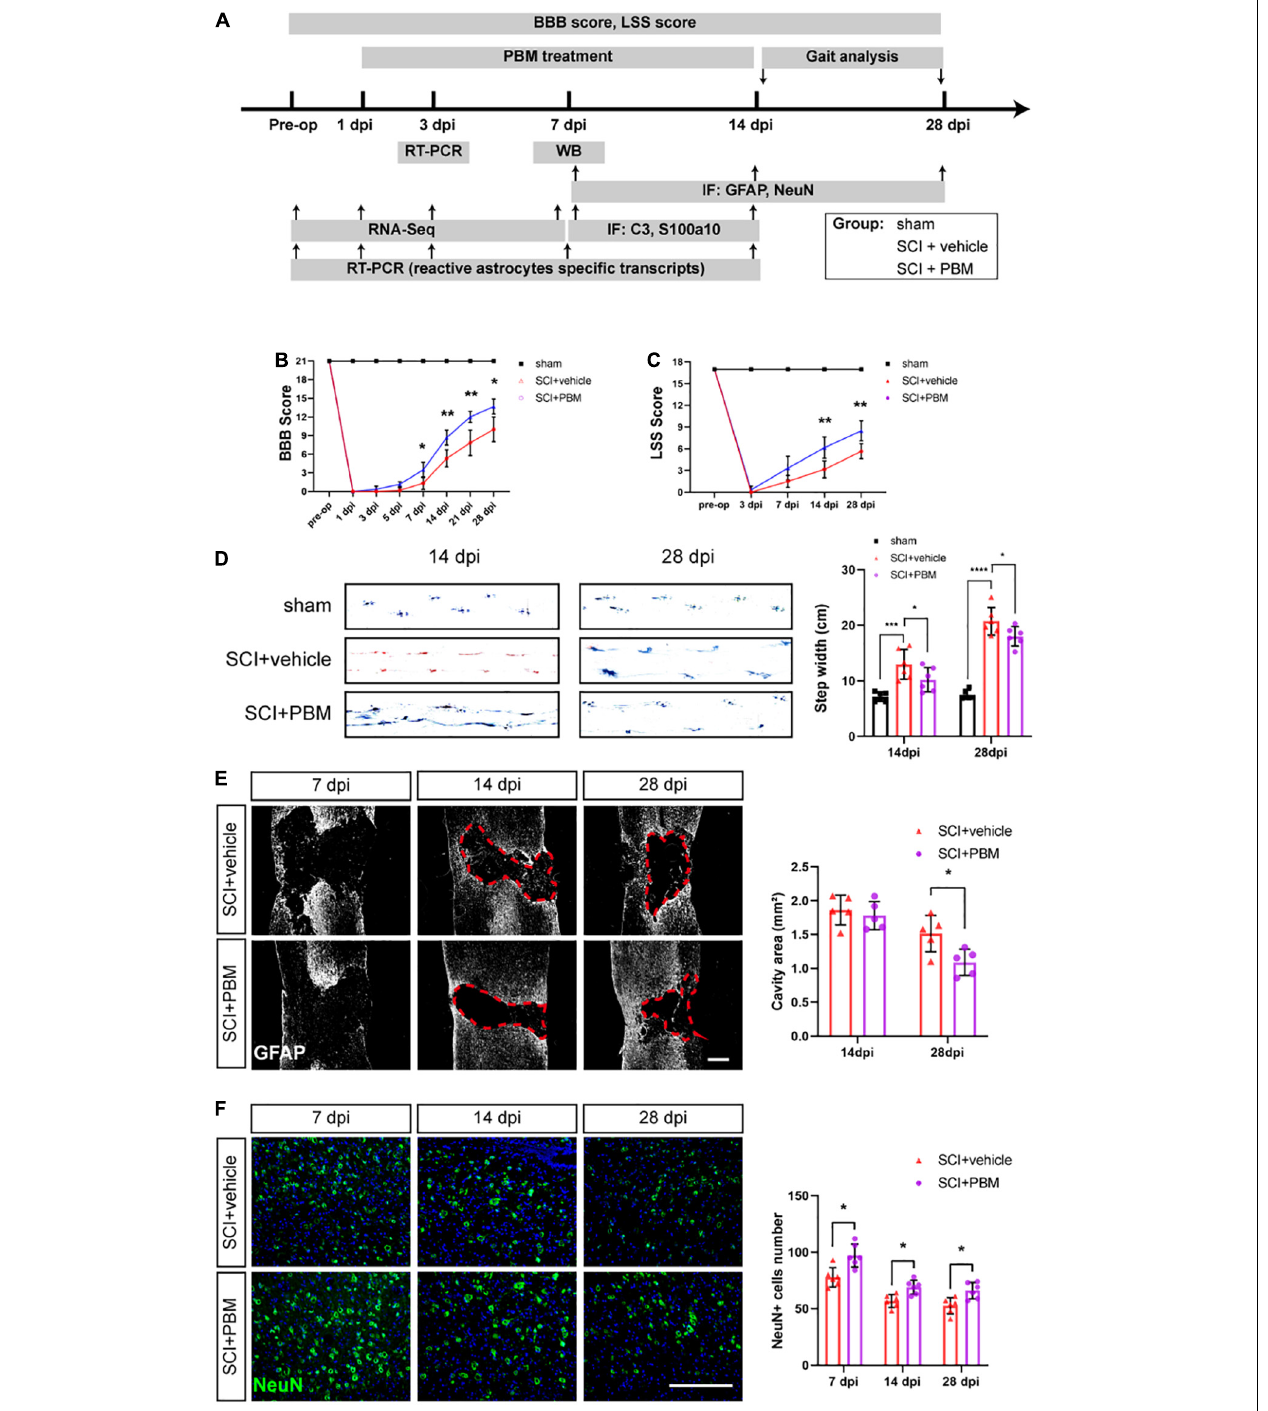
FIGURE 1 | Photobiomodulation promoted motor recovery, reduced the lesion cavity size and increased the number of surviving neurons after SCI. (A) Timeline of the experimental design. (B,C) BBB scores and LSS scores were used to evaluate the motor function of each group ( n = 6 individuals per group). (D) Representative footprints from each group at 14 and 28 dpi obtained by gait analysis. The average step width was calculated ( n = 6 individuals per group). (E) Representative images of immunofluorescence staining of GFAP in spinal cord tissue from the SCI + vehicle and SCI + PBM groups at 7, 14, and 28 dpi. Quantification of the cavity area of spinal cord lesions at each time point ( n = 5 individuals per group). Scale bar: 400 µ m. (F) Representative images of immunofluorescence staining for NeuN in the ventral horn of the spinal cord within ± 150 µ m from the lesion epicenter. Quantification of the number of NeuN + cells in the SCI + vehicle group and SCI + PBM group at each time point ( n = 6 individuals per group). Scale bar: 200 µ m. * p < 0.05, ** p < 0.01, *** p <